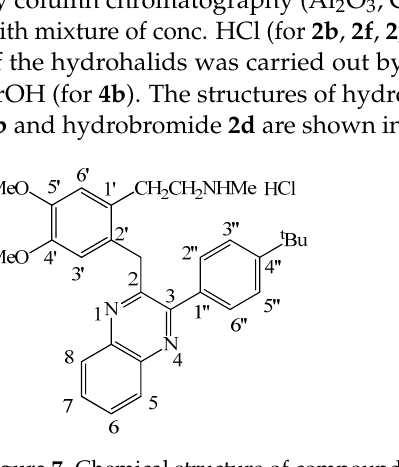
Figure 7. Chemical structure of compound 2b .